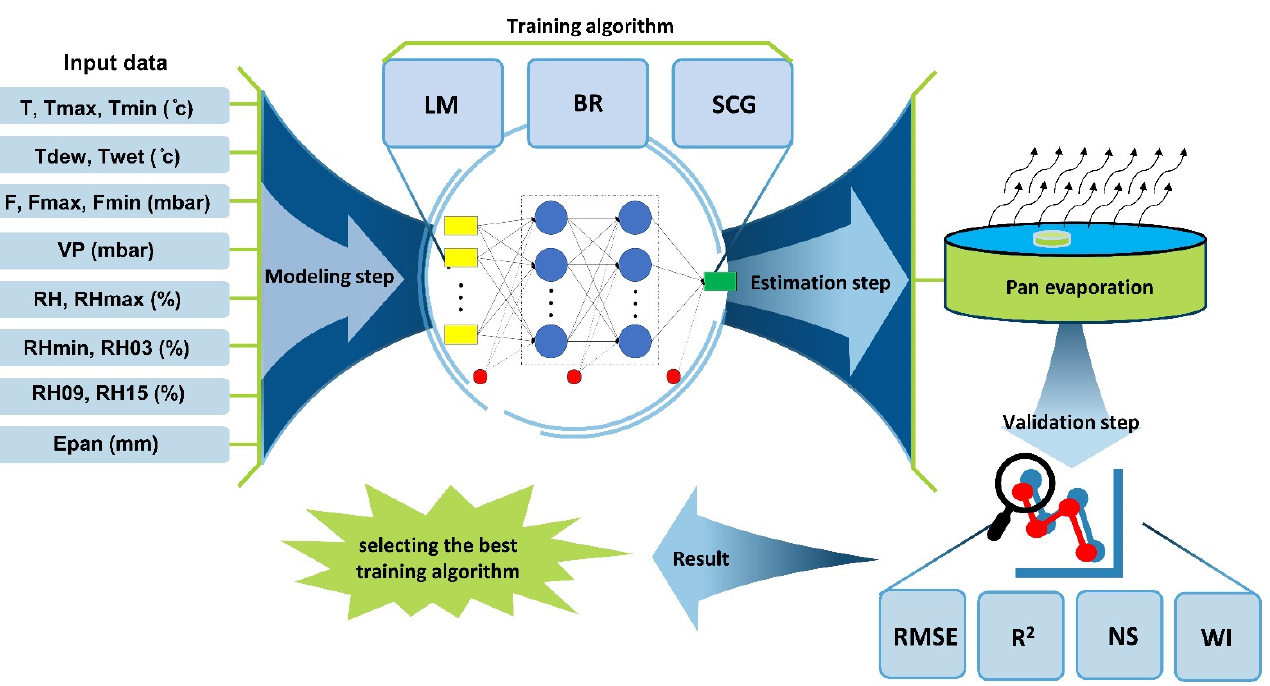
Figure 3. The general flowchart of the current study’s modeling steps.